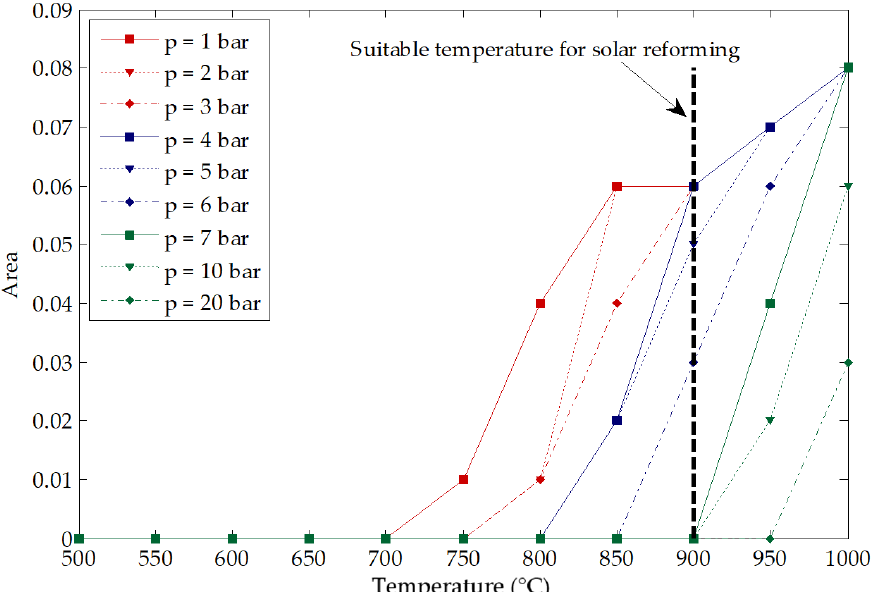
Figure 3. Area of suitable inlet compositions in color map.